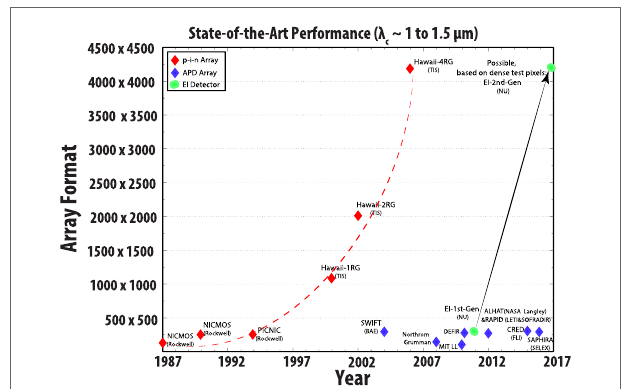
FiGURe 2 | The trend in array size for state-of-the-art SwiR imaging arrays with cutoff wavelength ( λ c ) ~1–1.5 μ m over the past 30 years: array format for p–i–n detectors have continued to increase is in proportion to the ability of readout integrated circuit technology to process the detector array signals. For APDs, on the other hand, array size and pixel pitch are limited fundamentally as a result of the high electric fields in the device and the super-exponential gain characteristic of detector with bias voltage . Array size of Northwestern University’s (NU) first-generation EI detectors is also marked in the plot. On-going efforts are currently for the development of large-format EI detector arrays using second-generation EI devices. Data obtained from Hodapp (2000), Bai et al. (2004, 2008b), Baker et al. (2004), Destéfanis et al. (2011), McKeag et al. (2011), Finger et al. (2012), Jack et al. (2012), and Feautriera et al.